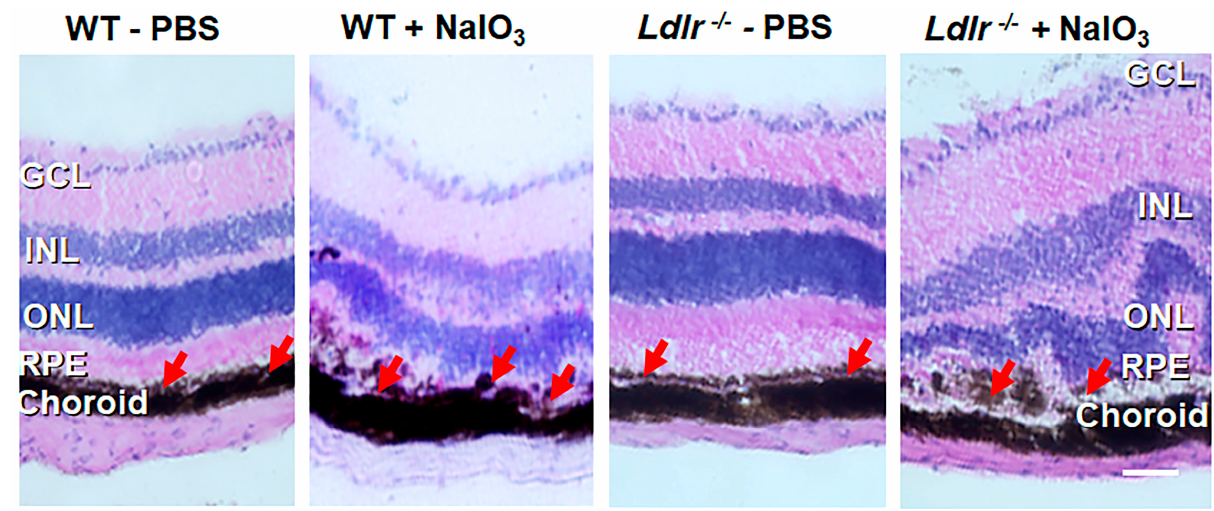
Figure 5. Histopathology of the retina from PBS and NaIO 3 -treated WT and Ldlr -/- mice. Seven days after tail vein injection of 20mg/kg NaIO 3 , H & E staining was performed. The RPE layer is marked with red arrows in all panels. The epithelial RPE monolayer was entirely disrupted, and RPE cells showed a rounded, degenerative phenotype (see arrows) in NaIO 3 -treated groups. Predominant loss of RPE cells, distortion and thinning of ONL, and disorganization of INL and atypical folds in the outer retina was observed in Ldlr -/- mice after NaIO 3 administration. Representative images from 6–8 animals are shown. Scale bar: 25 µm.